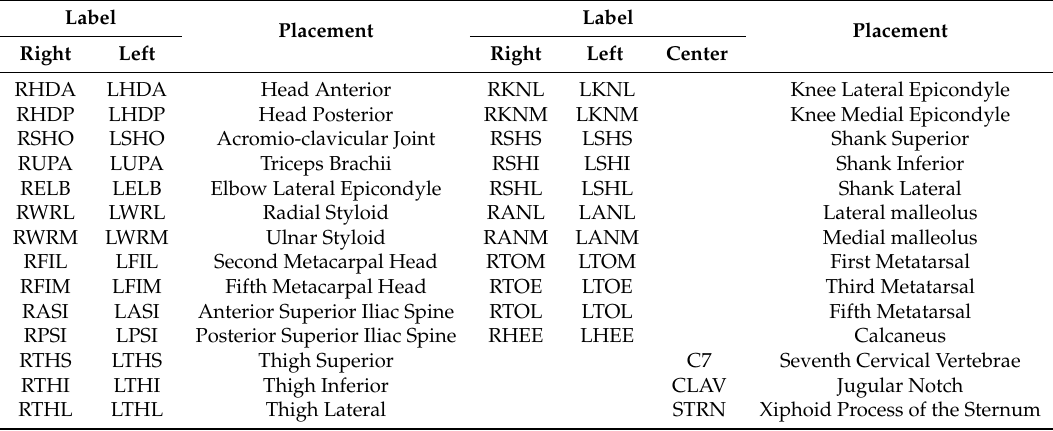
Table A1. Marker protocol, indicating the marker labels and placement locations on the human body. Label Label Placement Placement Right Left Right